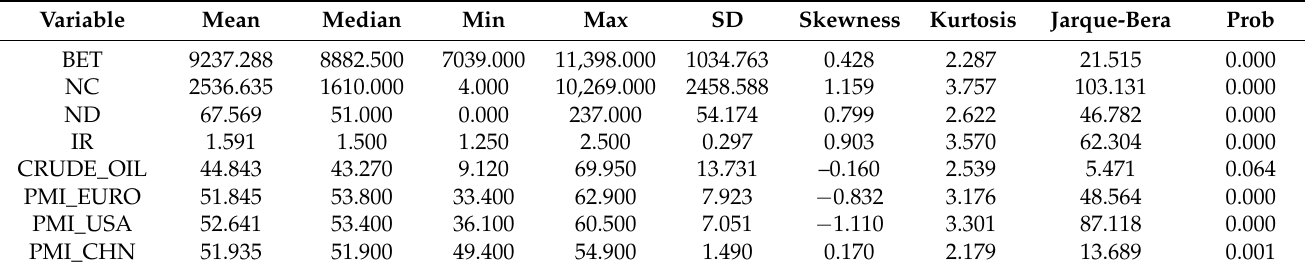
Table 2. Descriptive statistics of the